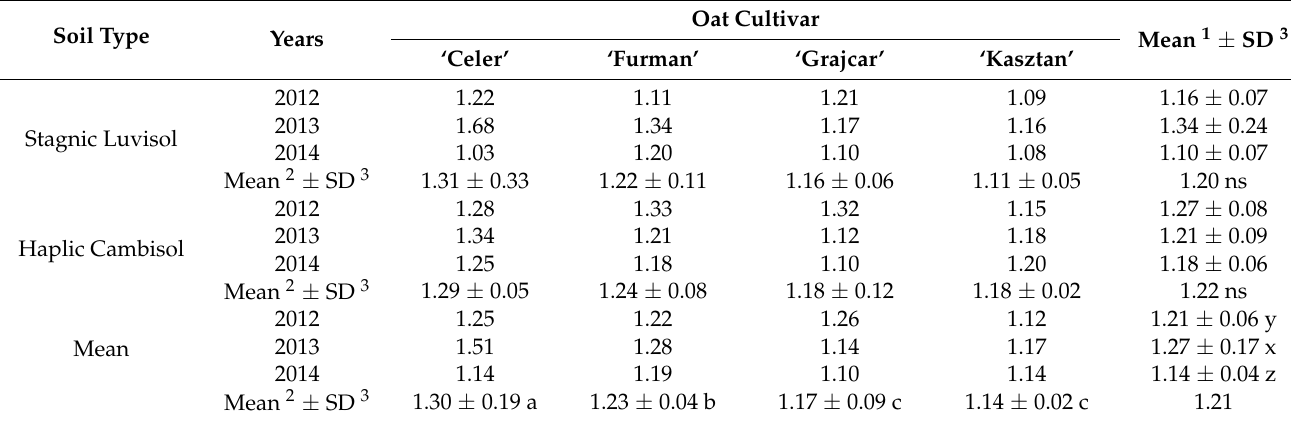
Table 5. Number of oats’ tillers in mixtures depending on the soil type (factor I), oat cultivar (factor II), and study years (factor